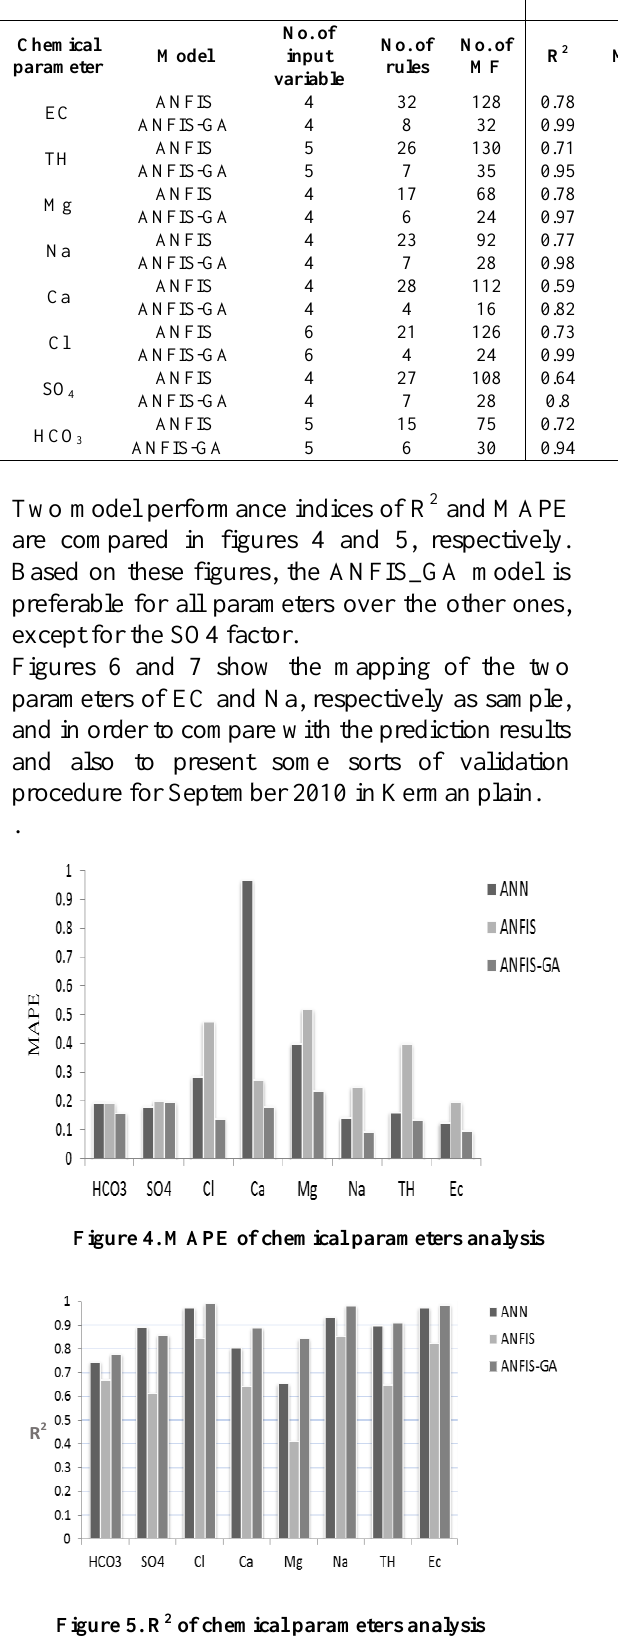
Figure 7. Observed and predicted (EC) fortest period on Kerman’s